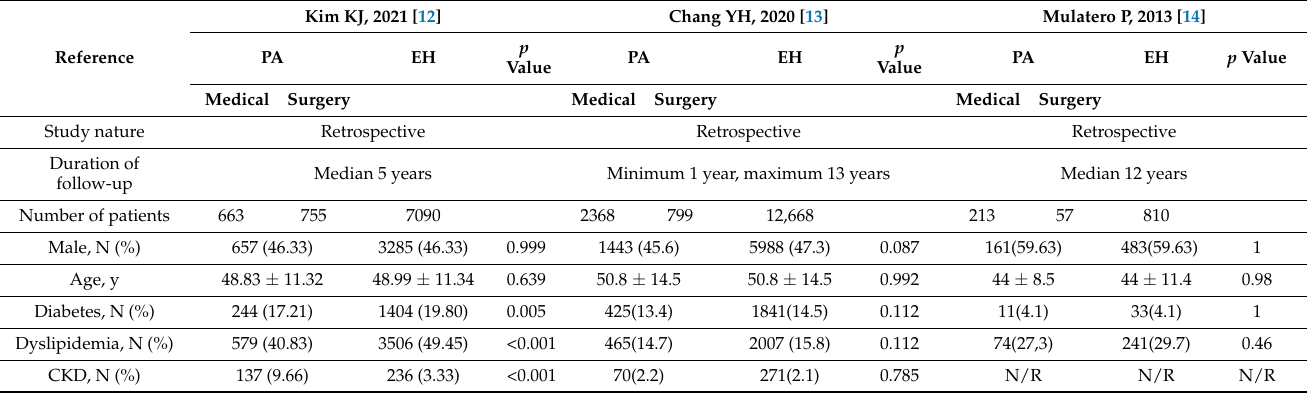
Table 1. Characteristics of the trials included in the meta-analysis.